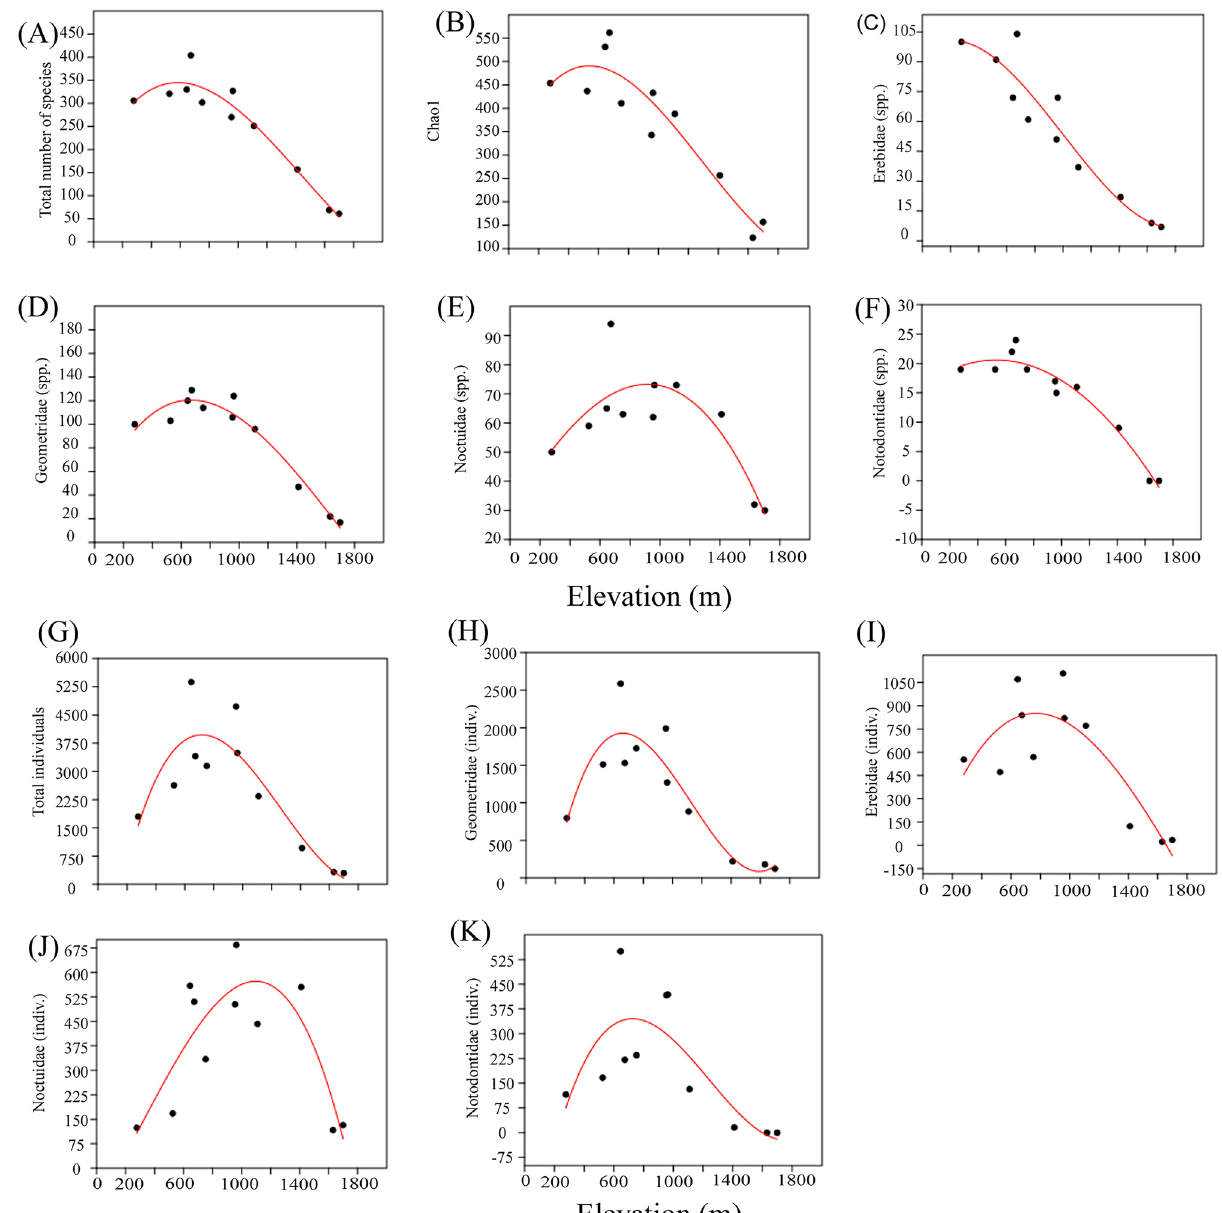
Figure 1. The best-fitted regression model for the species richness and abundance of moths along elevation in HNP. ( A ) Observed species richness, ( B ) Estimated species richness (Chao 1), ( C ) Species richness of the Erebidae, ( D ) Species richness of the Geometridae, ( E ) Species richness of the Noctuidae, ( F ) Species richness of the Notodontidae, ( G ) Total abundance, ( H ) Abundance of the Geometridae, ( I ) Abundance of the Erebidae, ( J ) Abundance of the Noctuidae, ( K ) Abundance of the